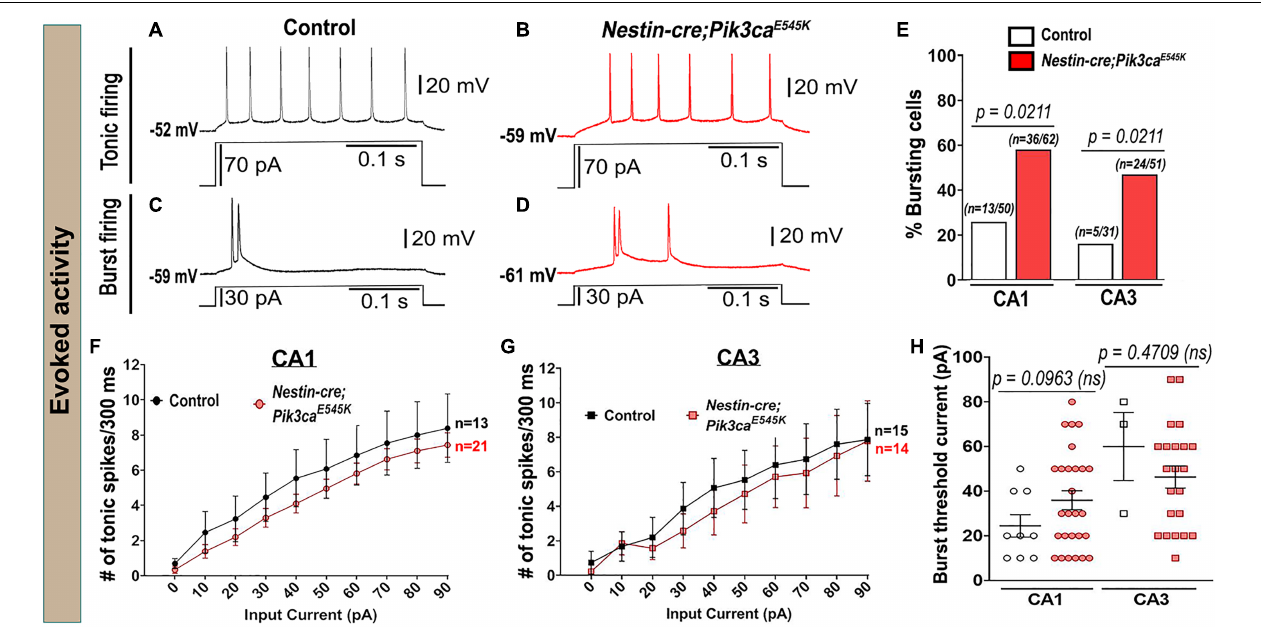
FIGURE 3 | Evoked whole-cell recording shows increased bursting in mutants. (A–D) Representative evoked voltage traces of control and mutant showed tonic and burst firing in response to current steps. (E) Evoked recording also marked significantly higher bursting cell proportions in the mutant. (F,G) No significant differences in evoked tonic spike frequencies were observed in the tested range of input depolarizing current (0–90 pA), between control and mutant CA1 and CA3 neurons (CA1: F = 13.07, df = 320; CA3: F = 4.844, df = 270). (H) No overt differences in the current inducing the first burst were observed between control and mutant (CA1: t = 1.744, df = 20.29; CA3: t = 0.8493, df = 2.439). Data is represented as bar graphs, mean ± SEM scatter and line plots; differences were considered significant at p < 0.05; ns, not significant. Scale bars: 0.1 s, 20 mV (A–D)